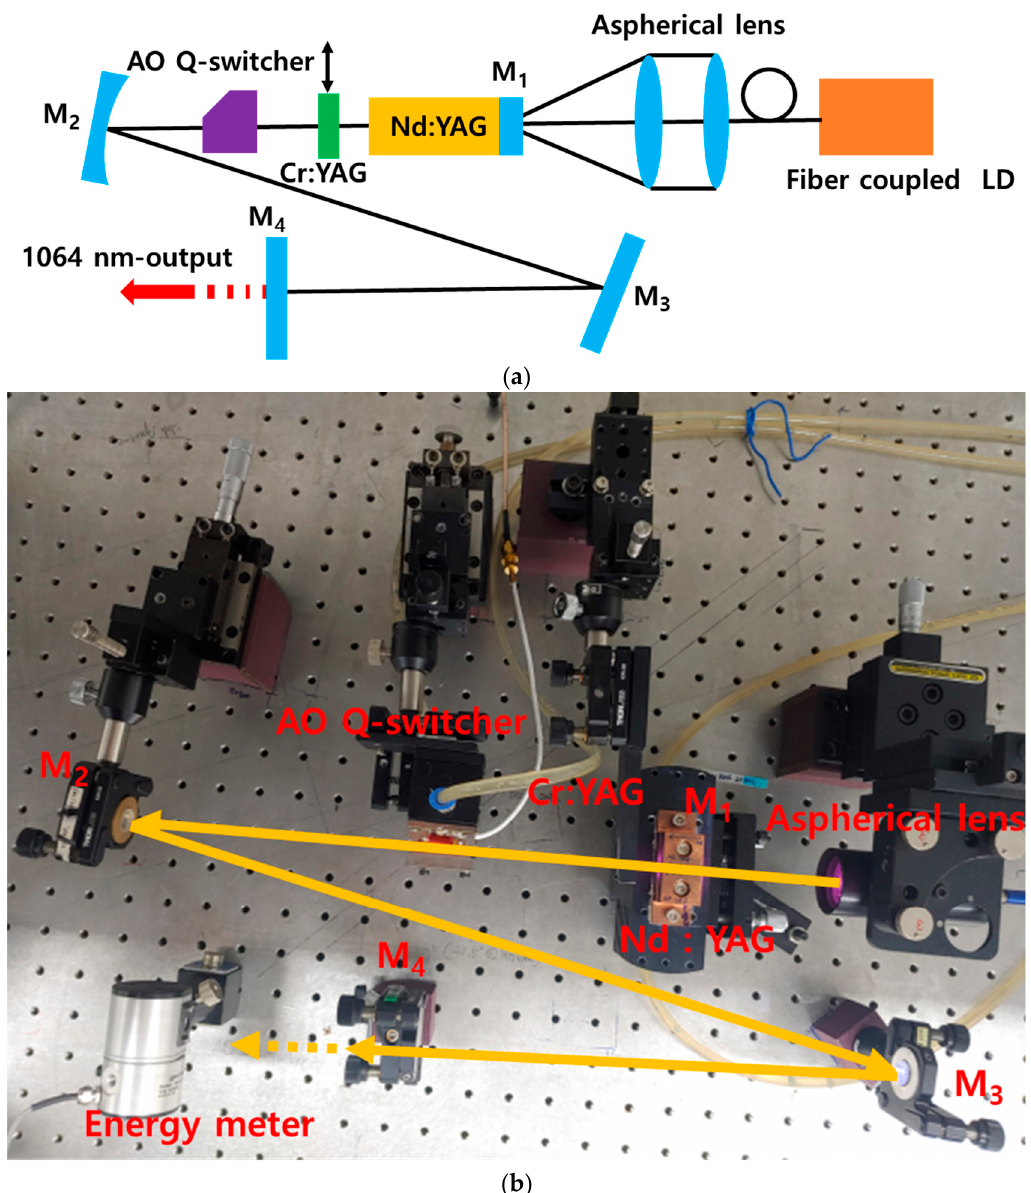
Figure 1. ( a ) Schematic of the developed doubly Q-switched Nd:YAG laser and ( b ) the implemented laser optical system.